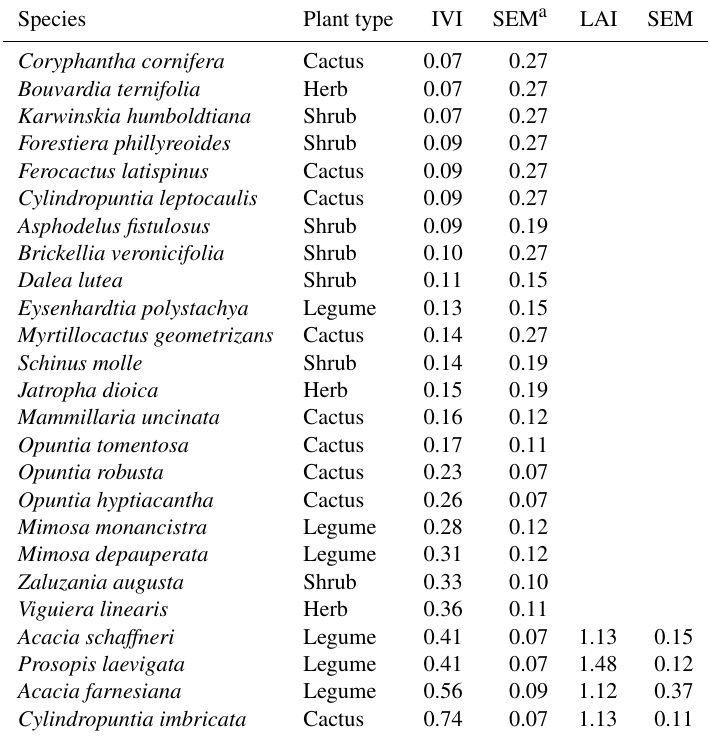
Table 2. Importance value index (IVI) and leaf area index (LAI) of the main species present at the Bernal, Querétaro, study